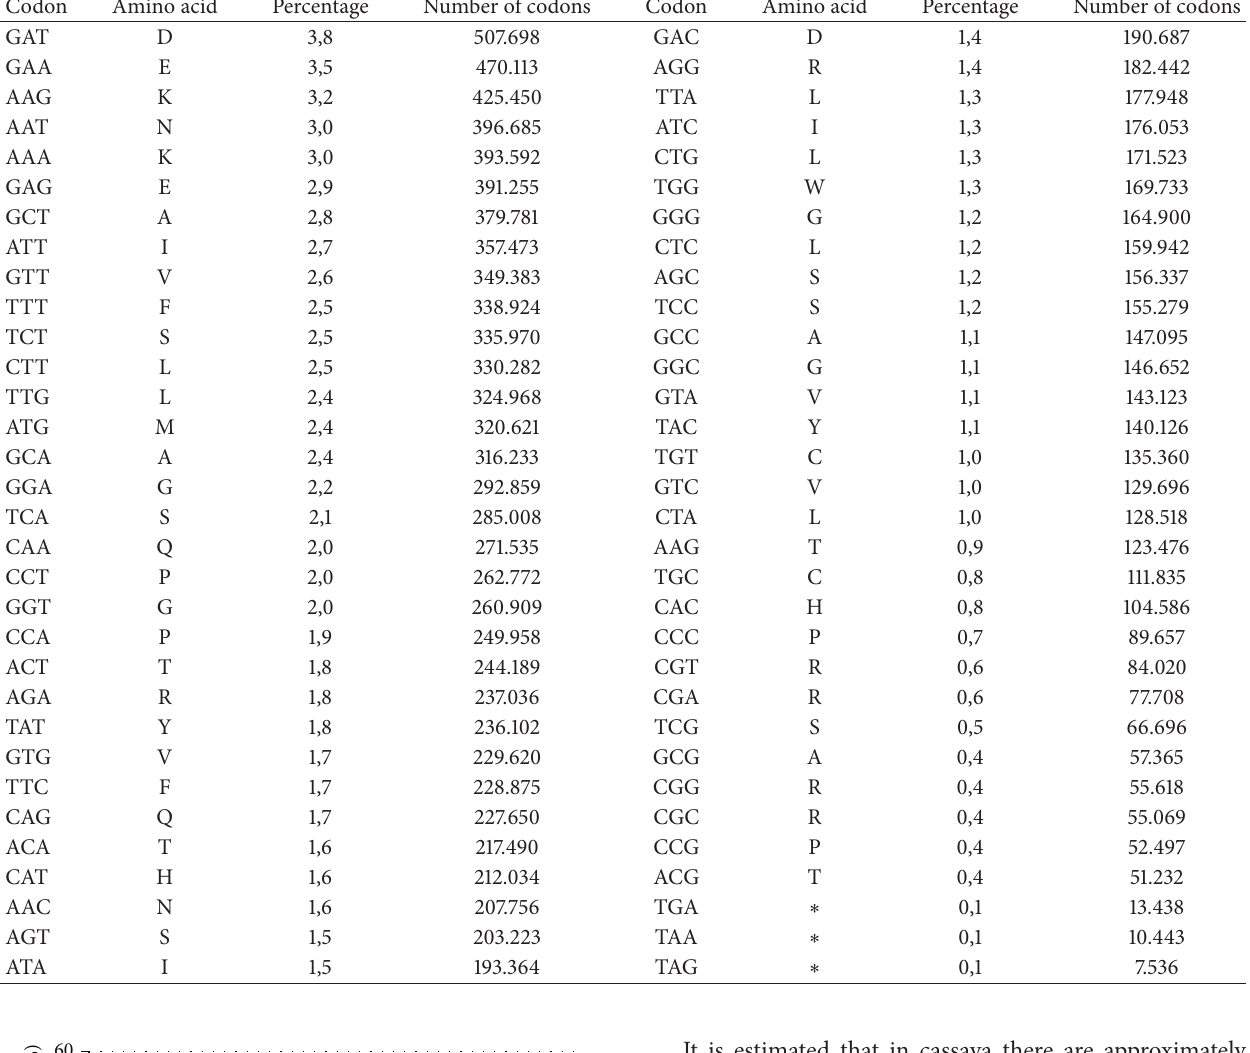
Table 1: Codon usage in cassava.